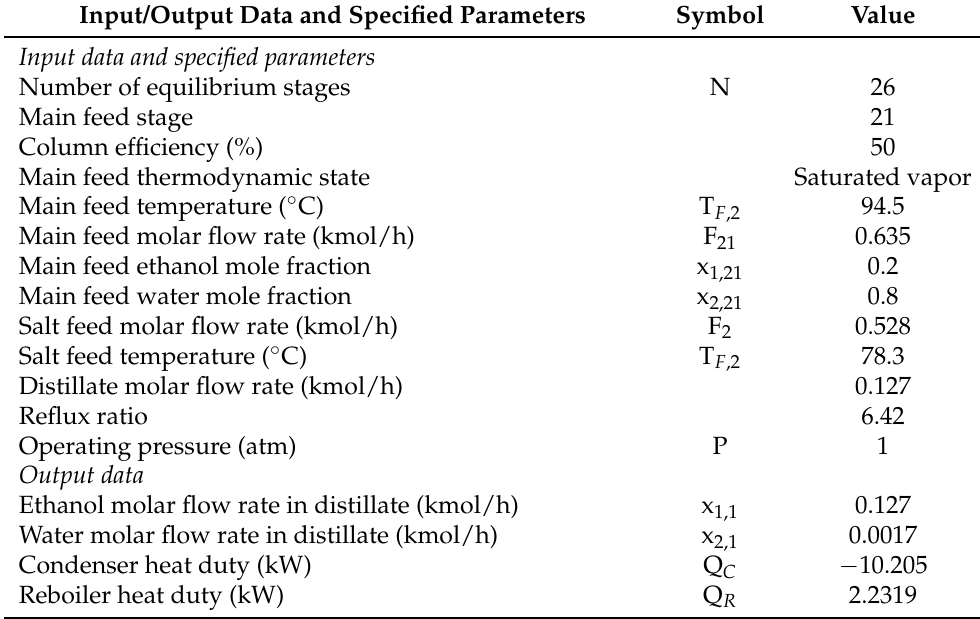
Table 1. Input data, specified parameters, and overall output data for the simulation of the saline extractive distillation column with CaCl 2 as a separating